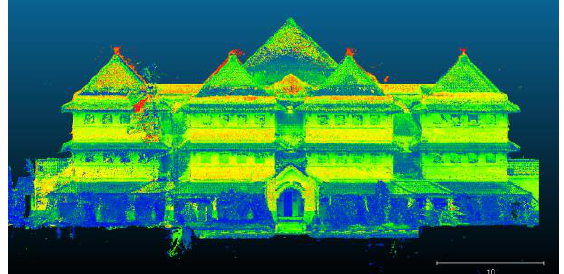
Figure 2. Library of ITB Jatinangor dense cloud